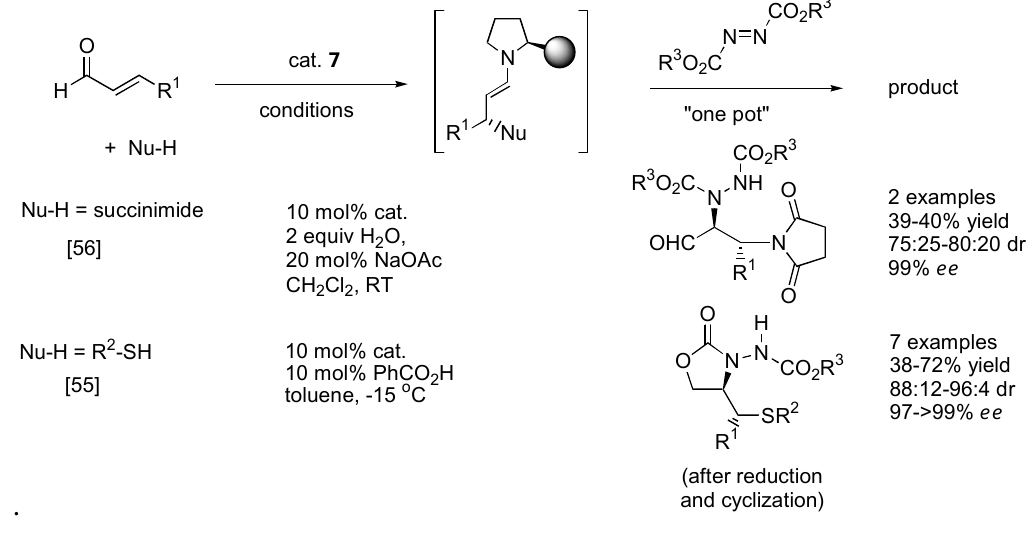
Figure 13. Tandem hetero-Michael addition-  -amination of  ,  -unsaturated aldehydes [55,56].